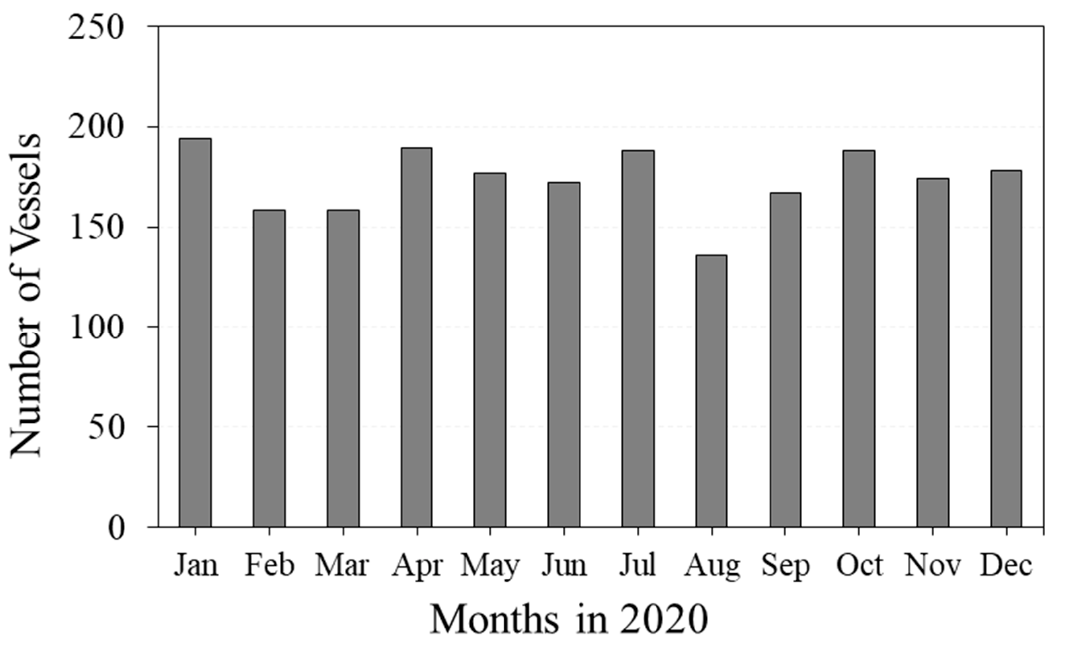
Figure 5. Number of vessels in Beirut Seaport from January to December 2020 (source: port of Beirut: Port of Beirut http://www.portdebeyrouth.com (accessed on: 17 November 2022).